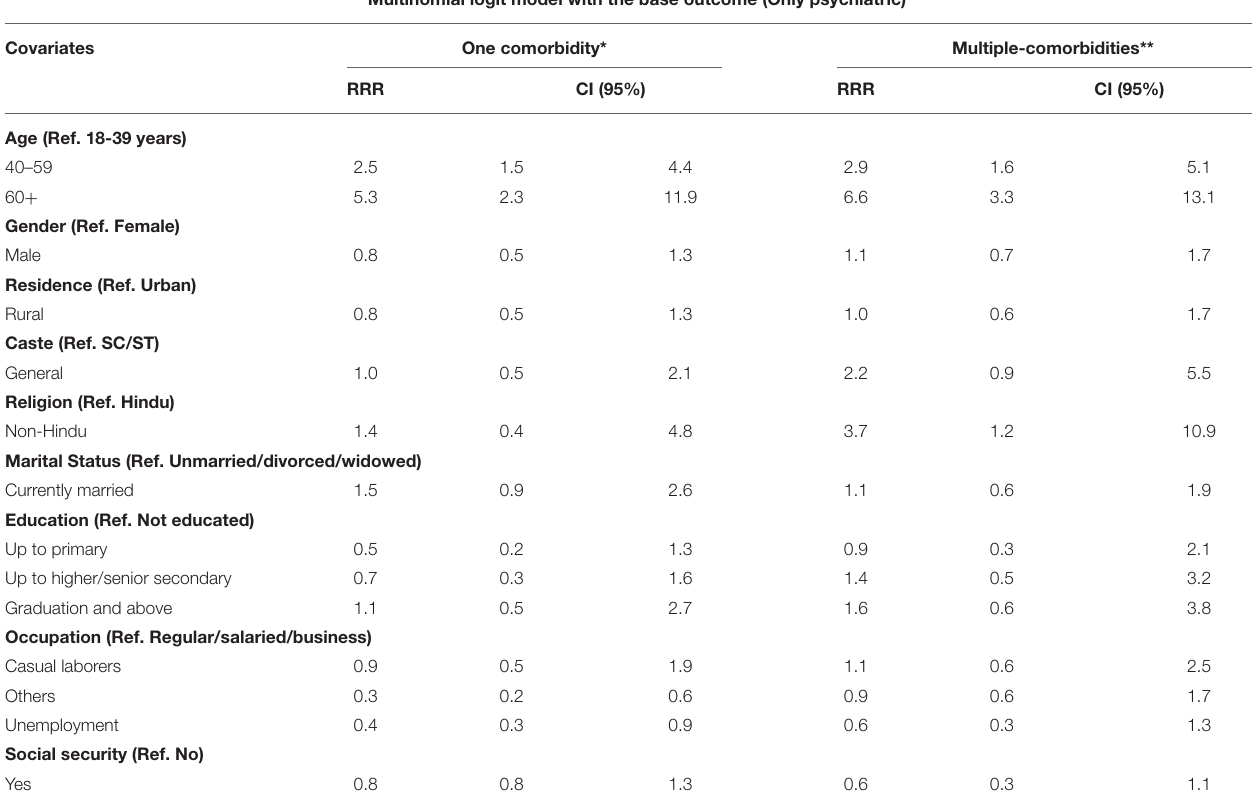
TABLE 3 | Results from Multinomial logistic regression analysis.